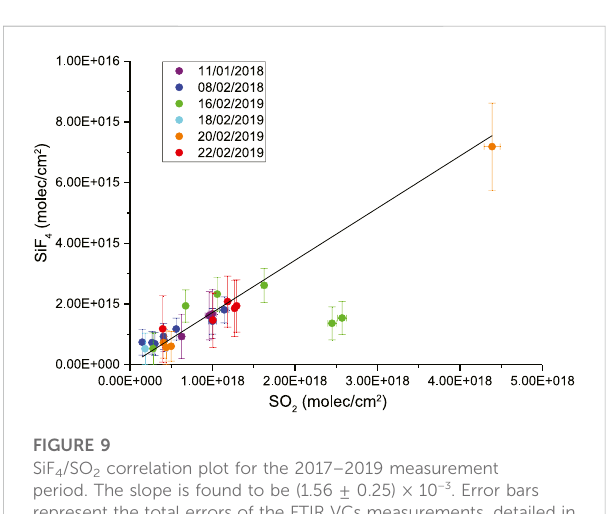
FIGURE 9 SiF 4 /SO 2 correlation plot for the 2017 – 2019 measurement period. The slope is found to be (1.56 ± 0.25) × 10 − 3 . Error bars represent the total errors of the FTIR VCs measurements, detailed in the